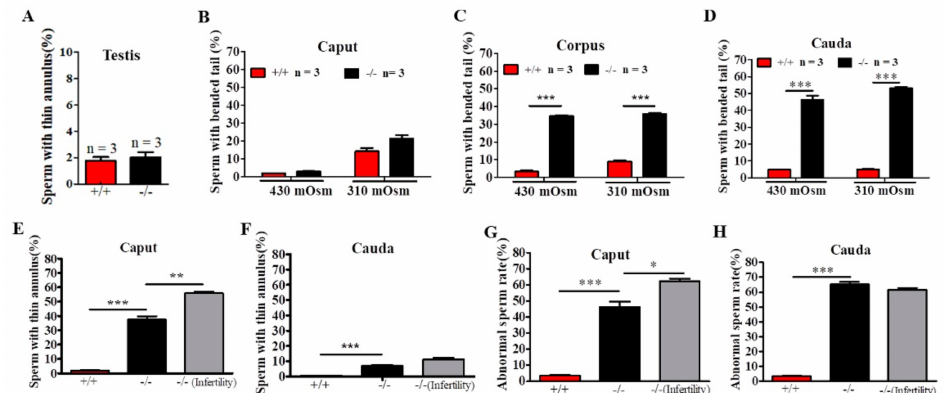
Figure 4. The site of the onset of structural defects of sperm flagella in calcium-binding protein spermatid-associated 1 knockout ( Cabs1 − / − ) mice. ( A – C ) Enumeration of angulated spermatozoa in the three distinct regions of the epididymis indicated that the structural defect of bent tails occurred during the transit of sperm through the Cabs1 − / − epididymis. Sperm with bent tails were counted under 430 and 310-mOsm high-salt buffers. ( D ) The percentage of sperm with a thin annulus in the testes in WT Cabs1 − / − mice. ( E , F ) The percentage of sperm with a thin annulus in the caput and cauda of epididymis were calculated in WT and fertile and infertile Cabs1 − / − mice. ( G , H ) Total abnormal sperm rates in the caput and cauda of the epididymis were calculated in WT and fertile and infertile Cabs1 − / − mice. Data in bar graphs are presented as mean ± SE. * p < 0.05, ** p < 0.01, and *** p < 0.001.